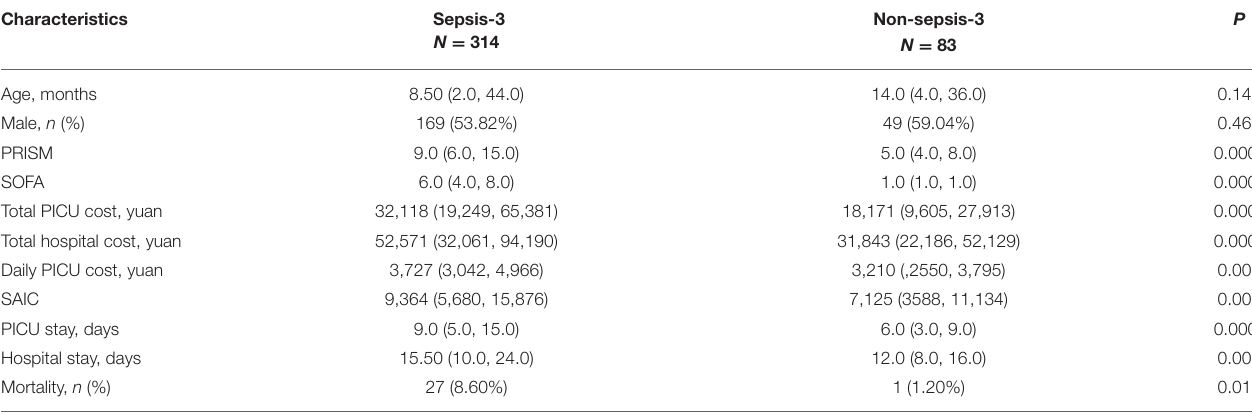
TABLE 2 | Comparison of patients with and without sepsis-3 definition sepsis.